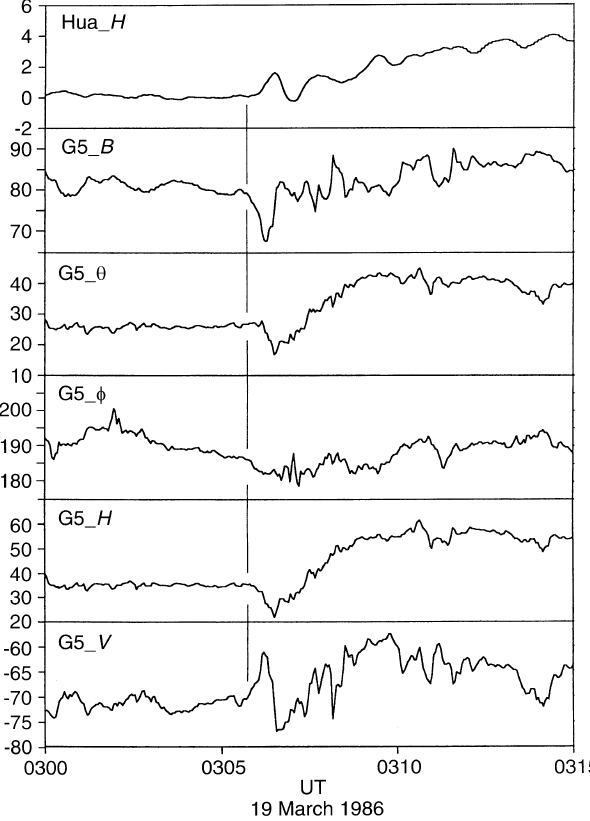
Fig 4. A 15-min plotout of the Pi 2 event of event 1 (19 March 1986). From top to bottom, Hua_H for the ground fluxgate data for the H component at the dip-equator (Huancayo), and B , (cid:104) , (cid:47) , H and V components for the satellite fluxgate data obtained by geosynchro- nous satellite GOES 5. The scales shown in the vertical axis are in nT for the Hua_H and satellite B , H , and V , while (cid:104) , and (cid:47) are shown in degrees. The vertical bar indicates the expected onset of the field changes at GOES 5